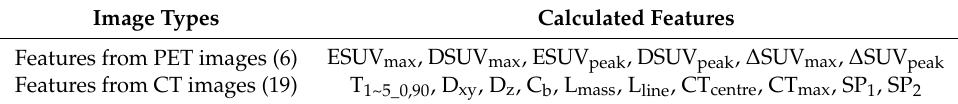
Table 2. Calculated features from positron emission tomography (PET) and computed tomography (CT)